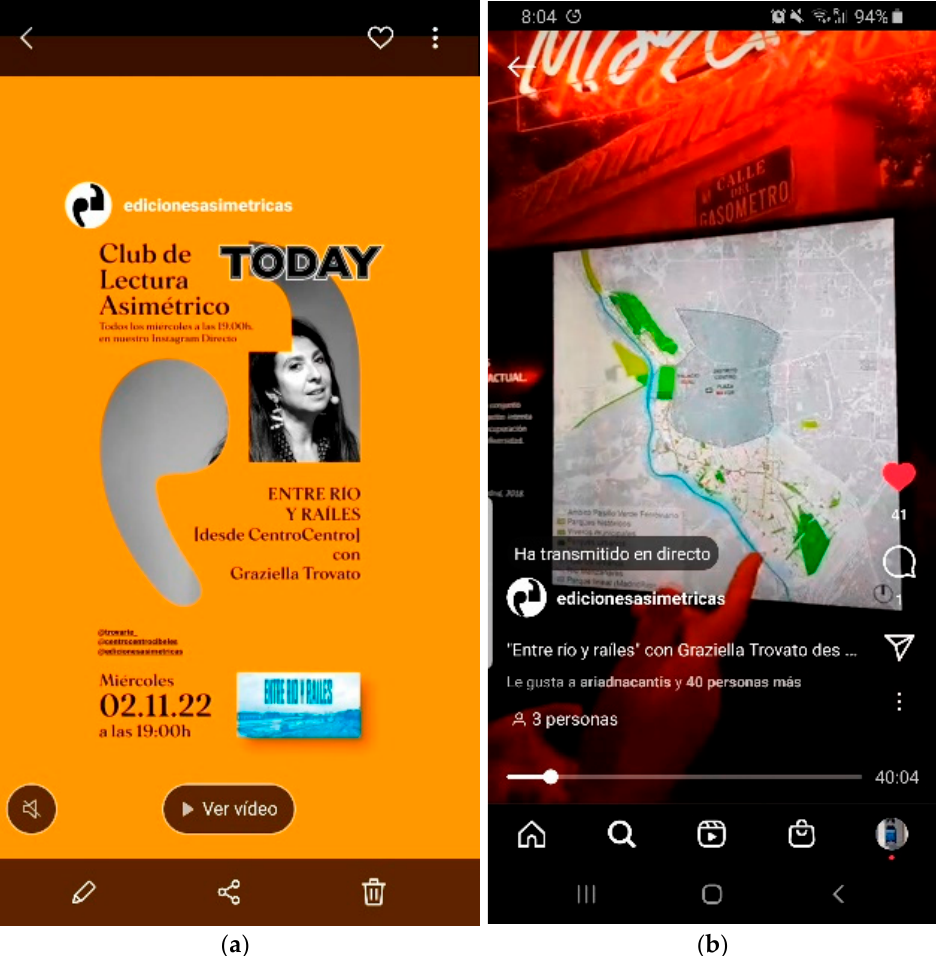
Figure 12. One-hour Instagram Live guided tour showing all the results and including the videos. ( a ) The banner; ( b ) an image of a moment of the video documentary “Las terrazas del Manzanares”. The video, which can be downloaded through this social network on the Asymmetric Editions profile, has so far registered 428 visits [22].